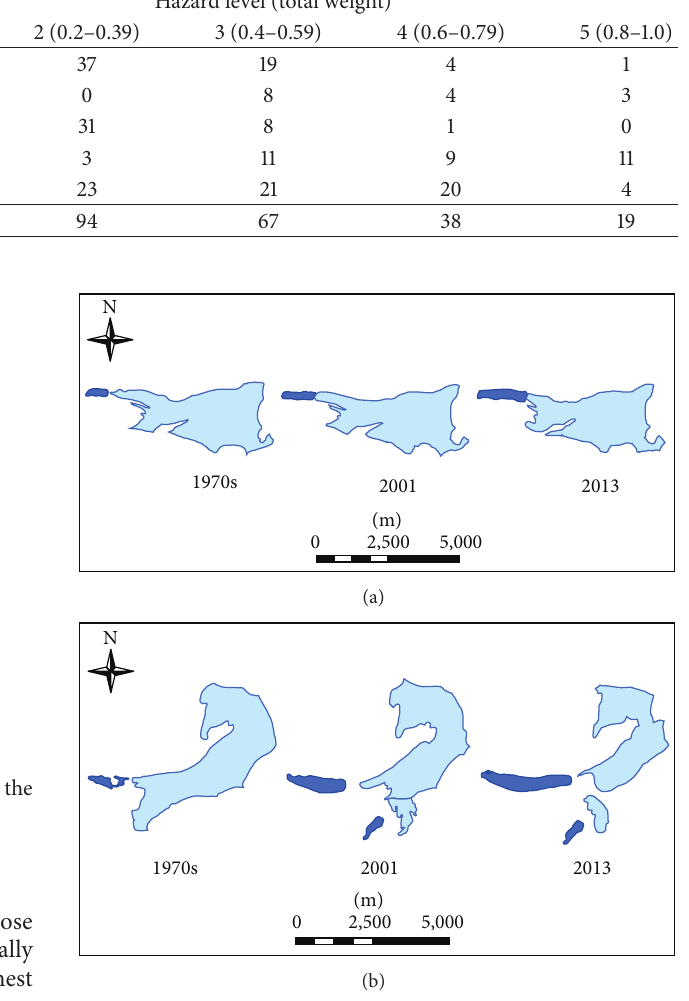
Figure 5: Morphological changes in two dangerous glacial lakes, (a) Gelhaipuco Lakeand (b)CoqongLake. (Darkbluerepresents glacial lakes while light blue represents